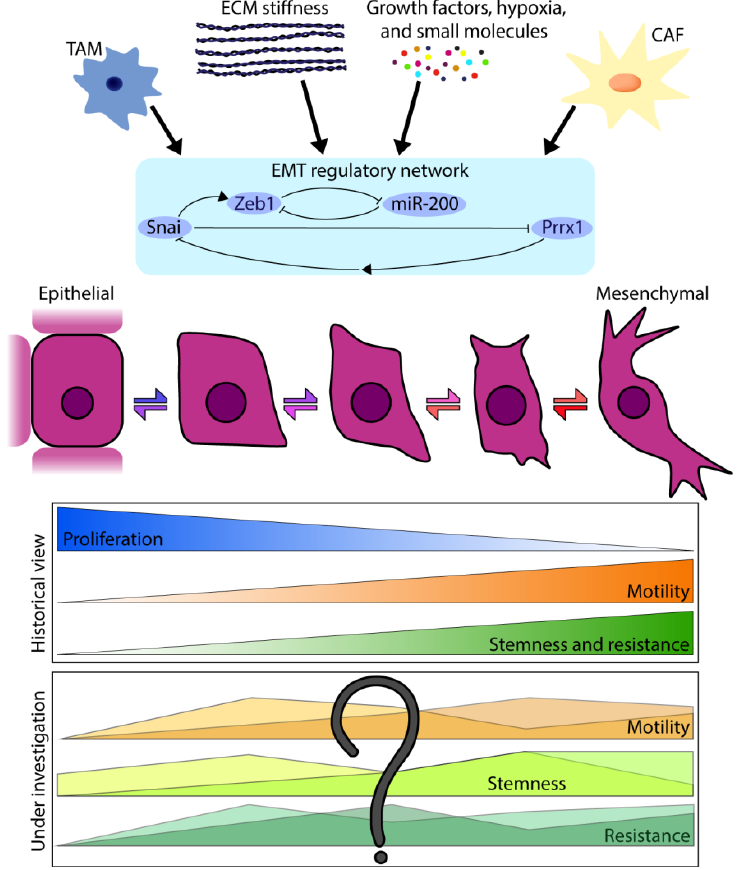
Figure 1. Overview of epithelial – mesenchymal plasticity